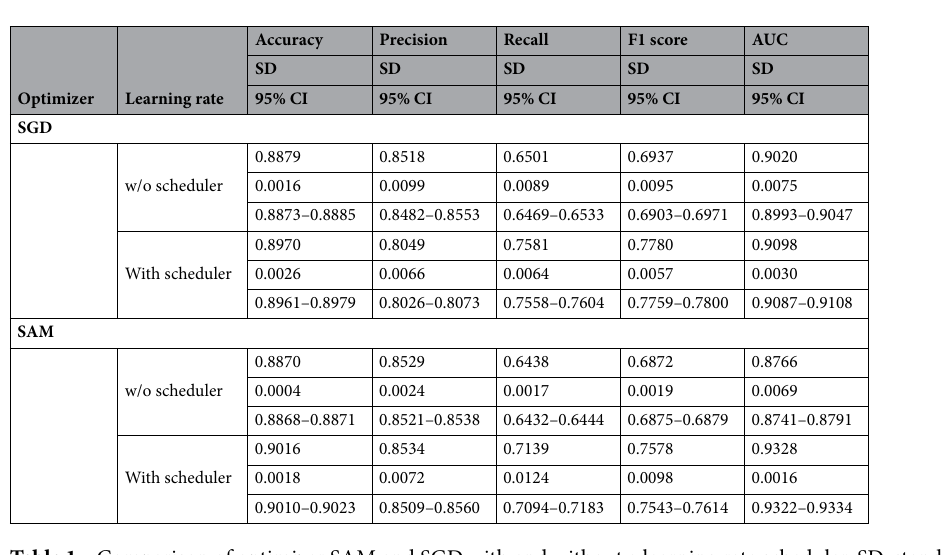
Table 1. Comparison of optimizer SAM and SGD with and without a learning rate scheduler. SD, standard deviation; 95% CI, 95% confidence interval; AUC, Area under the ROC curve.